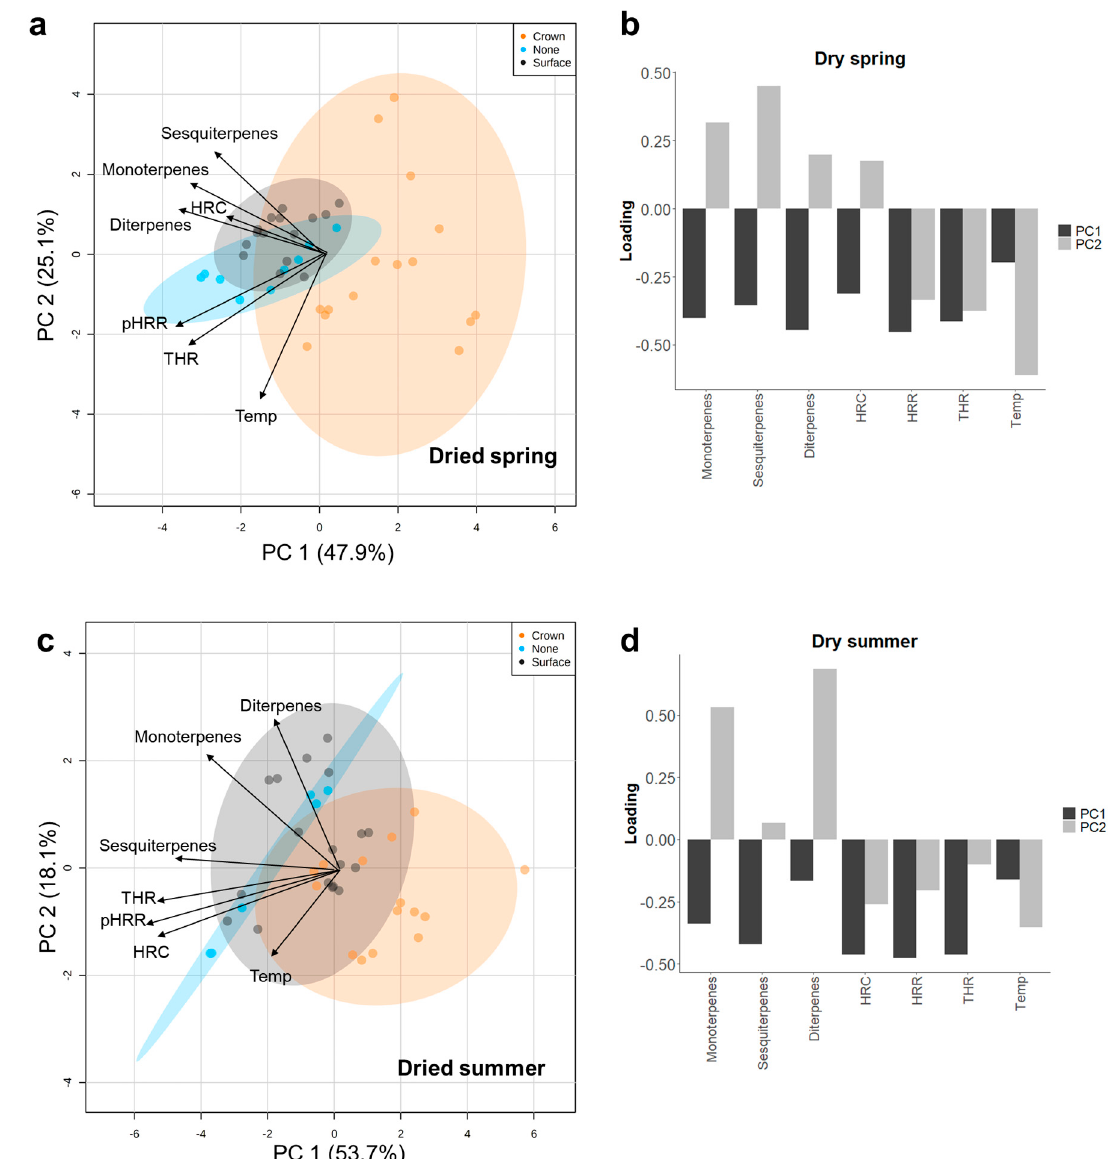
Figure 7. PCA of flammability traits in lab-dried needles ( a – d ). Principal component analysis of the terpene content and flammability characteristics of lab-dried pine needles, sampled in spring ( a ) and summer ( c ). Crown-fire species are represented in orange, surface-fire in grey and none-fire in open circles. Each point represents an individual replicate, with three replicates per species, and 95% confidence intervals for each fire regime are shown with ellipses. The contribution of individual factors to the first two principal components are indicated with labelled arrows ( a and c ) and are shown in ( b ) for spring data and ( d ) for summer data.